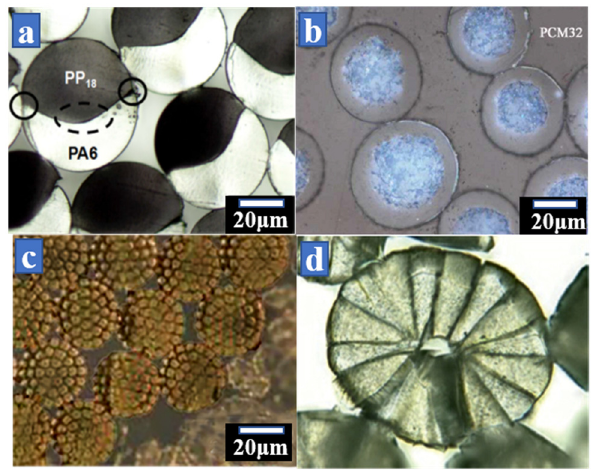
Figure 5: Cross - section of the fi ber characterized by optical micro - scopy: ( a ) side - by - side bicomponent fi ber with 50 wt% PP 18 /50 wt% PA6, ( b ) core/shell melt - spun PCM32 bi - fi bers, ( c ) islands - in - the - sea PTT/m - iPP ( 75/25 ) conjugated fi laments, and ( d ) segmented - pie PA6/PET bicomponent fi ber (× 1,000 ) . ( a ) Reproduced with permis - sion ( 111 ) Copyright 2016, ASM International; ( b ) adapted with permission ( 112 ) Copyright 2018, Express Polymer Letters;